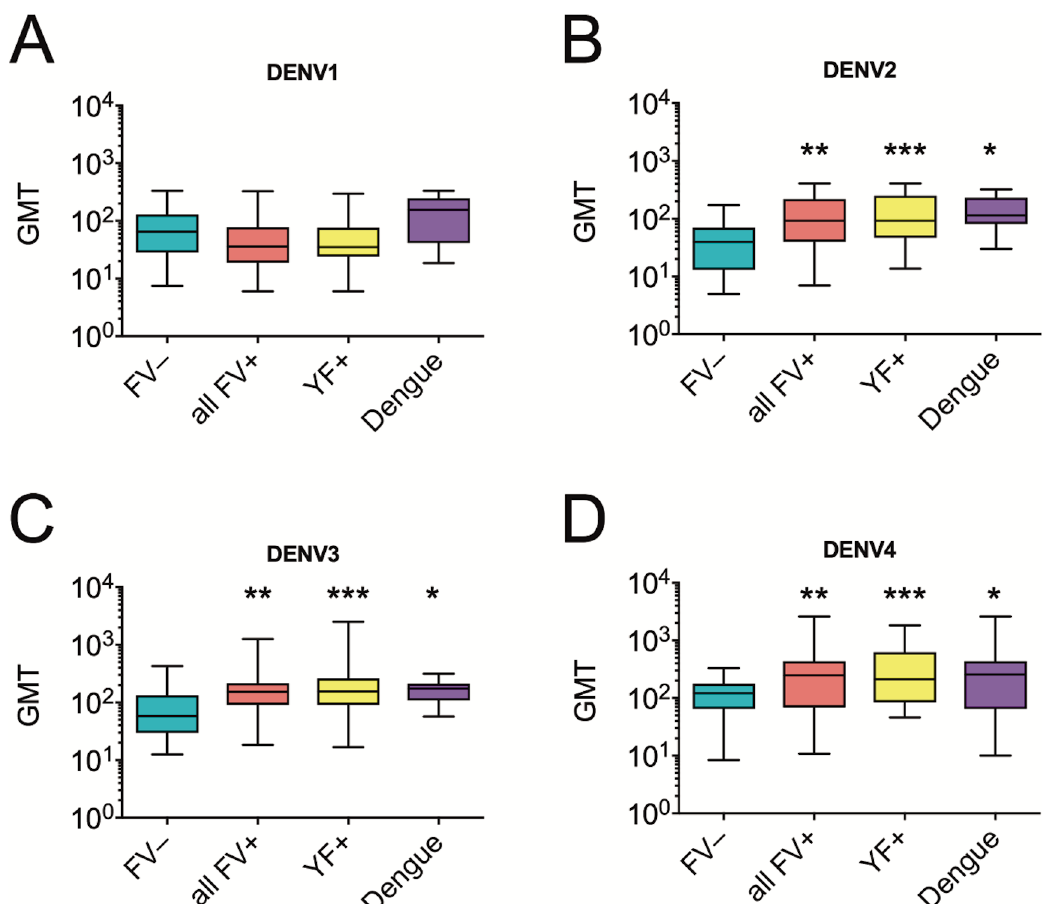
Fig 3. Mean peak neutralizing antibody titers (PRNT 50 ) for DENV-1( A ), DENV-2 ( B ), DENV-3 ( C ), and DENV-4 ( D) up to 90 days followingone dose of TV003 in flavivirus-na ï vesubjects (n = 58, from ref. [19]), all flavivirus-experienced (all FV +) subjects (n = 38) and by two subgroups–those with yellow fever virus (YF+, n = 31) or denguevirus exposure(Dengue, n = 11). All data represent mean titers (GMT) ± 95% confidenceinterval. Statistical significanceof the difference between FV-na ï vegroup was assessedby one-wayANOVA with Sidak correction for multiple comparisons. * , P < 0.05, ** , P < 0.01, *** P , <